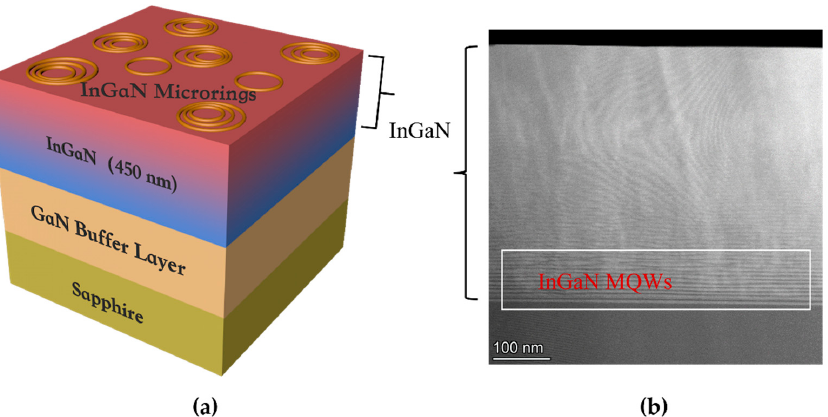
Figure 1. ( a ) Schematic illustration of the full-composition-graded In x Ga 1 − x N. ( b ) HAADF-STEM image of the full-composition-graded In x Ga 1 − x N.